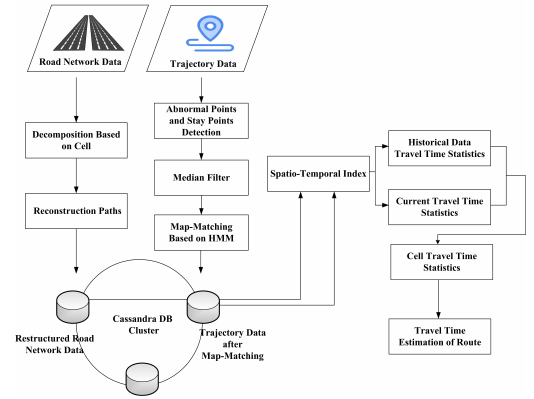
Figure 2. The framework of travel time estimation